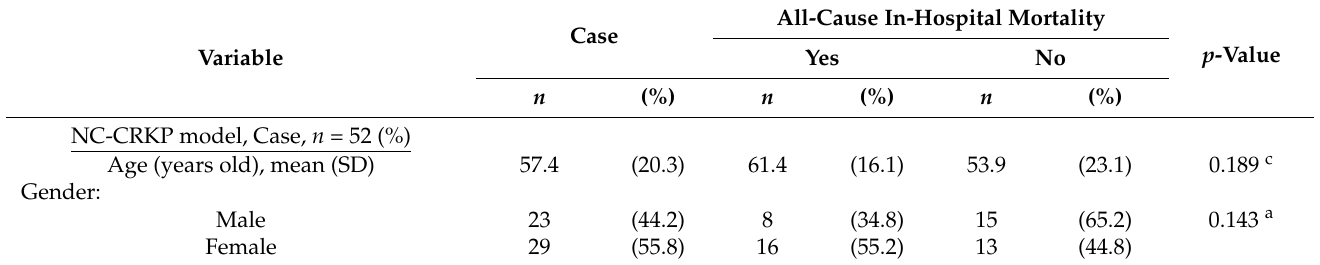
Table 6. Risk factors of NC-CRKP associated with all-cause in-hospital mortality by univariate